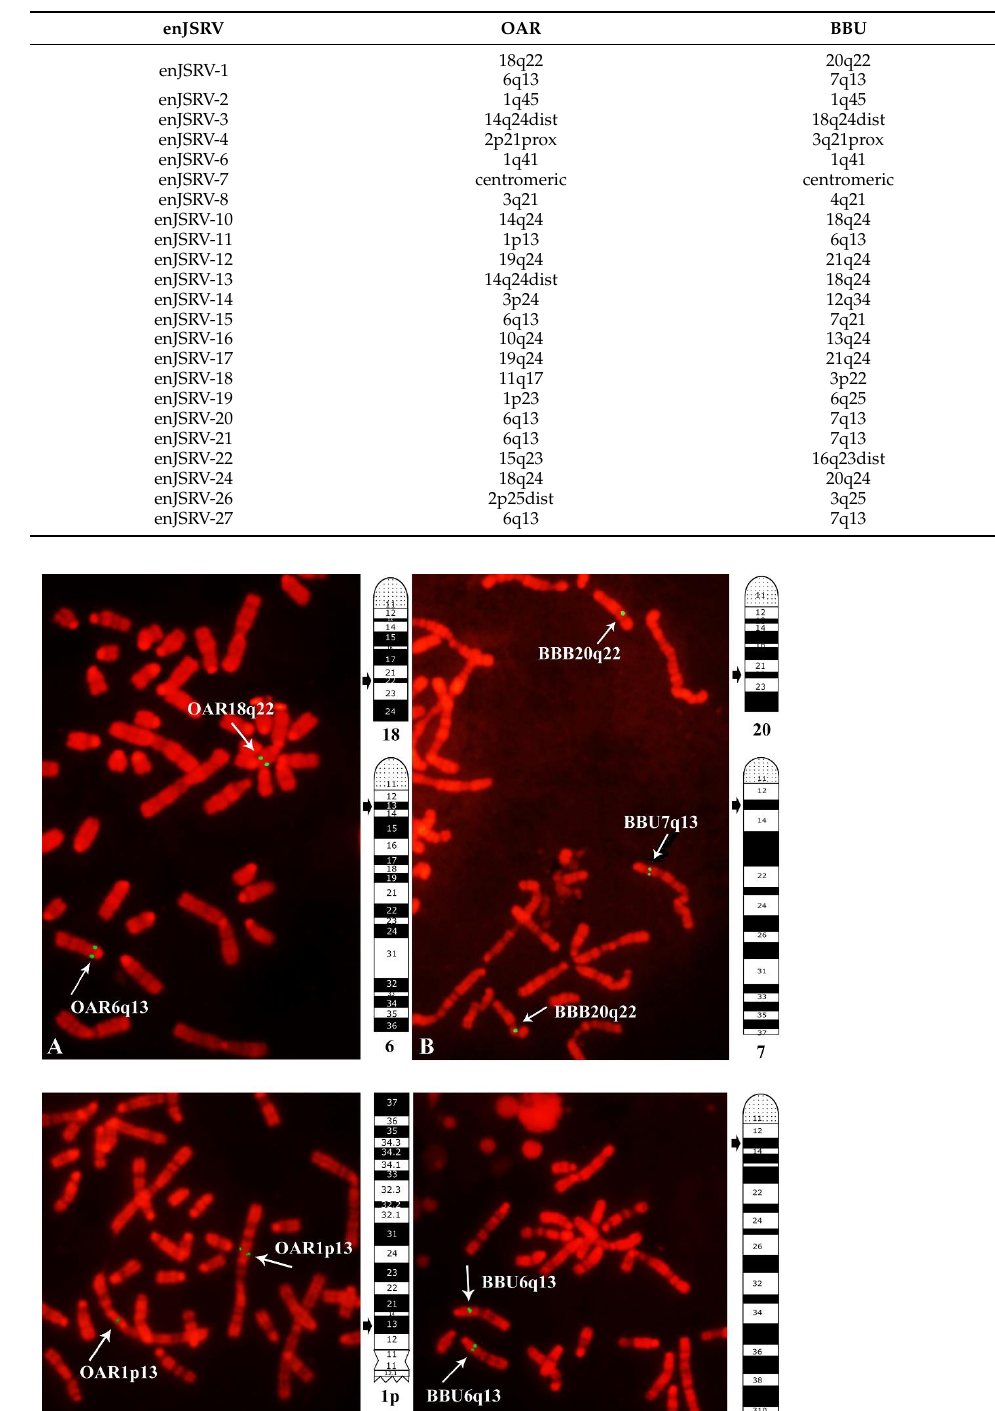
Table 2. Chromosomal localization of 23 enJSRVs in sheep (OAR) and river buffalo (BBU) chromo- somes by FISH-mapping.